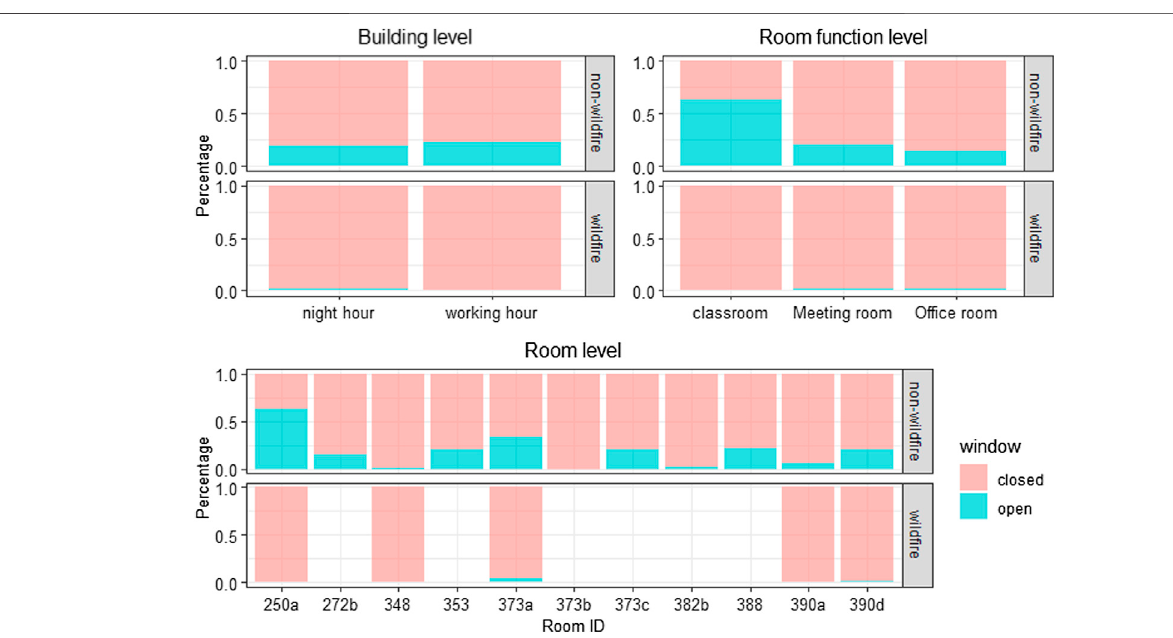
FIGURE 5 | Window usage at different